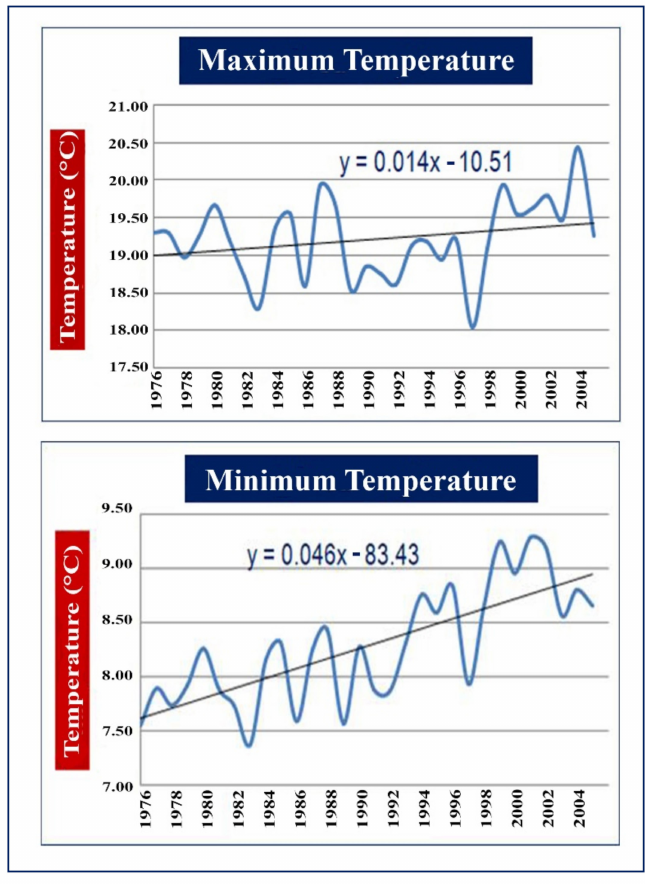
Figure 3. CRU observed annual average maximum and minimum temperature (1976–2005) represen- tation with trend